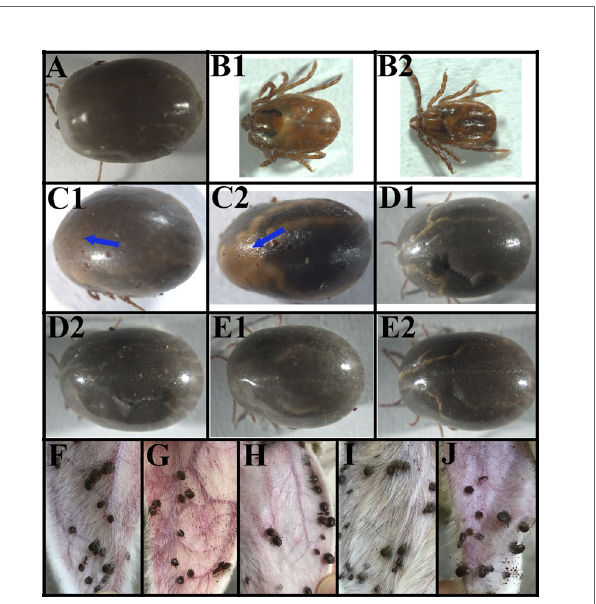
FIGURE 5 | Expression of vitellin 1 (Vn1) and vitellin 2 (Vn2) in SPK-silenced ticks relative to the control (dsRNA-GFP-injected group). The results are expressed as the means (n = 3) ± SEM.